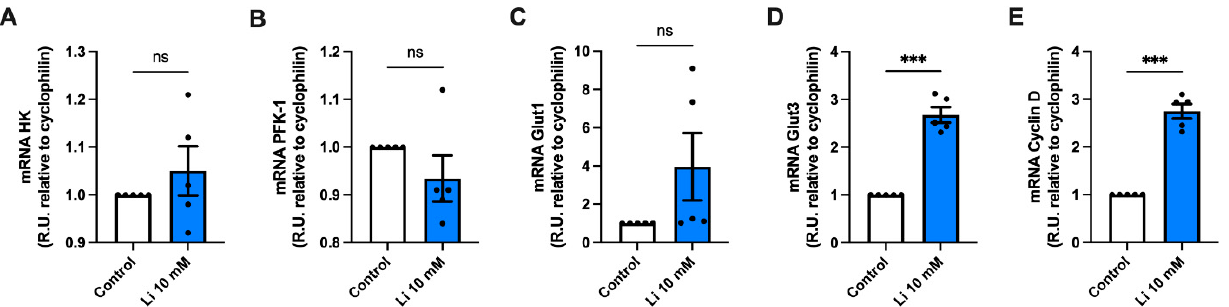
Figure 4. Lithium enhances the expression of neuronal glucose transporter 3 . ( A – E ) mRNA levels of hexokinase (HK), phosphofructokinase-1 (PFK-1), glucose transporter 1 (Glut1), Glut3, and Cyclin D1 (relative to cyclophilin) from hippocampal lysates, measured by qPCR. Data plotted as means ± SEM (n ≥ 4 independent cell culture preparations). *** p < 0.001 was determined by Student’s t -test; ns, not significant.